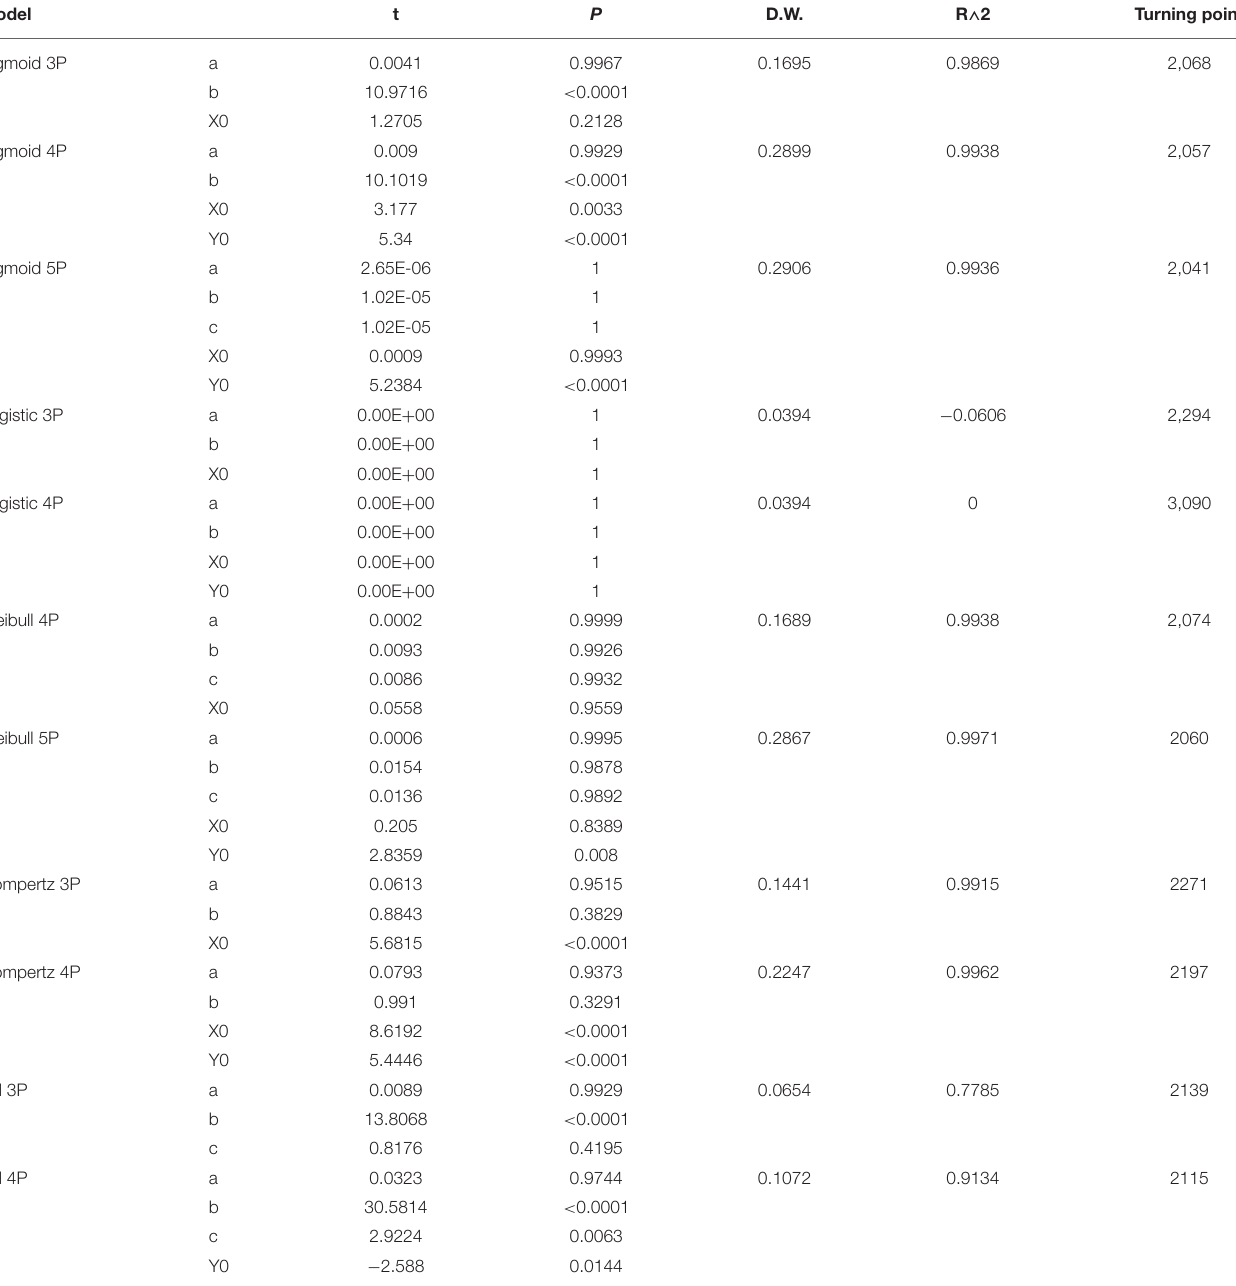
TABLE 1 | Nonlinear regression models for papers in cereal screening.